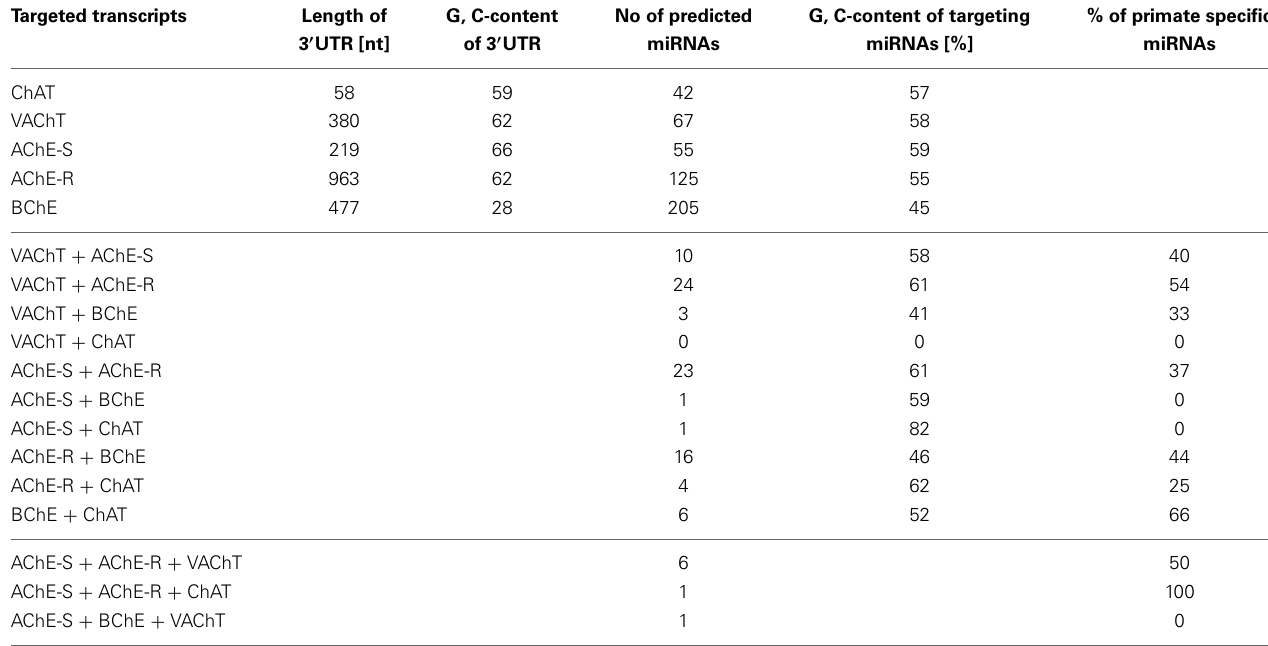
Table 1 | Overlapping miRs are largely